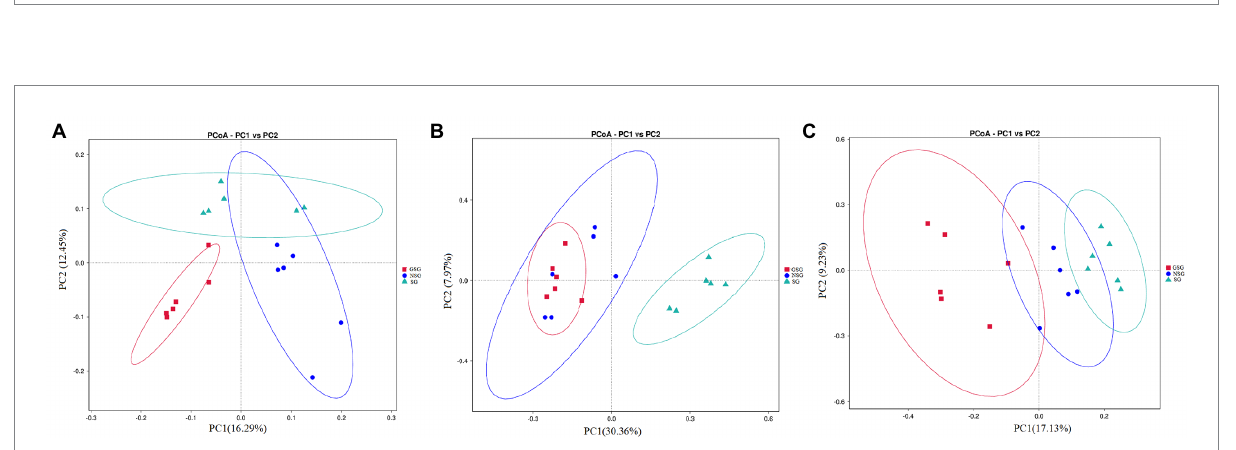
FIGURE 2 Principal coordinate analysis (PCoA) of rumen microbial communities. (A) Bacteria. (B) Fungi. (C)